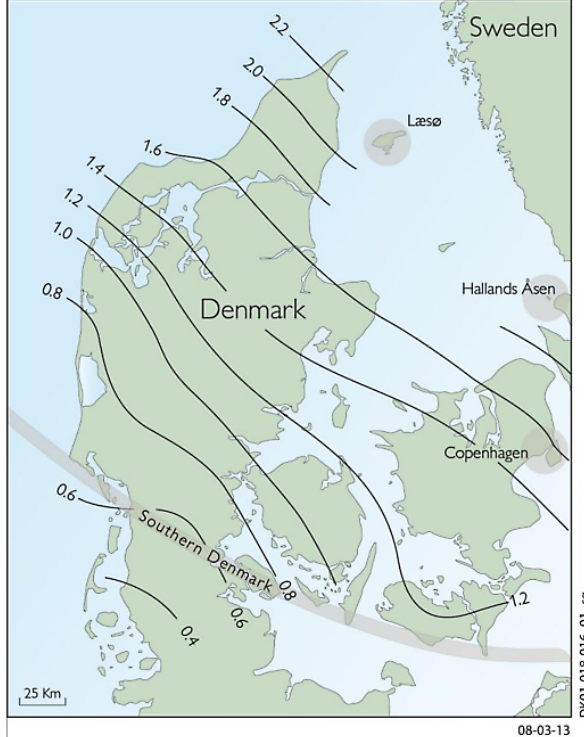
Fig. 3. Modern geodetic map (from Knudsen et al., 2012) with post- glacial uplift in centimetres per year. Based on GPS, levelling and sea level stations. Four treated claims of earthquakes or other irreg- ularities shown by grey